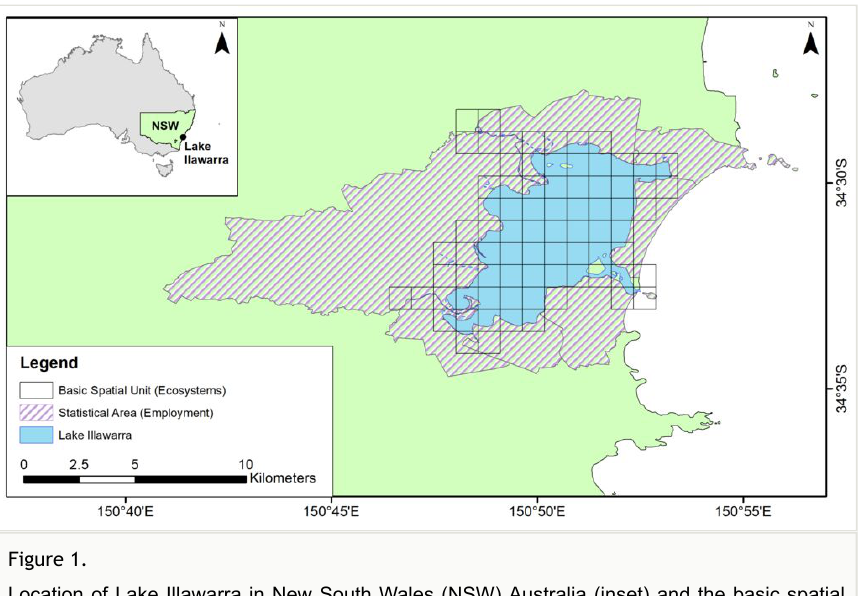
Figure 1. Location of Lake Illawarra in New South Wales (NSW) Australia (inset) and the basic spatial units (1 km grid, n = 73) used to measure mangrove, tidal marsh and seagrass in ecosystem accounting and (c) the seven level 2 statistical areas (SA2s) used in Australian Bureau of Statistics (ABS) census data used to estimate full-time equivalent employment